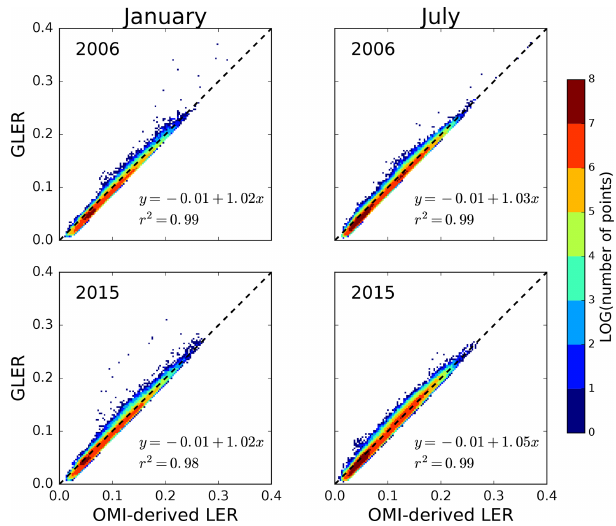
Figure 7. Scatterplots comparing GLER with OMI-derived LER at 466nm in January and July in 2006 and 2015, limited to rows 1– 20 to exclude OMI data affected by the row anomaly. Latitudes are restricted to those below 60 ◦ to avoid introducing complications of snow/ice misclassification in the comparison.